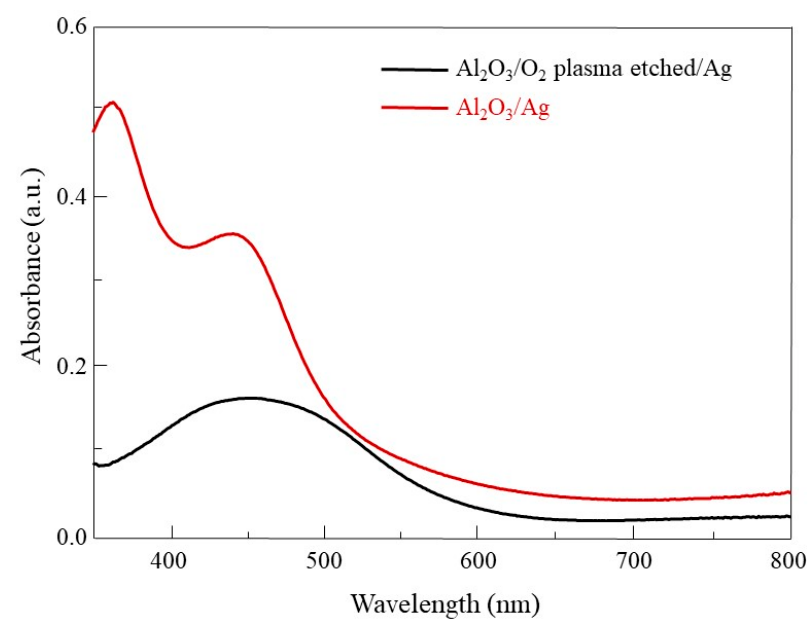
Figure 4. UV-vis spectra of Ag on sapphire(red) and O 2 plasma etched sapphire(black).